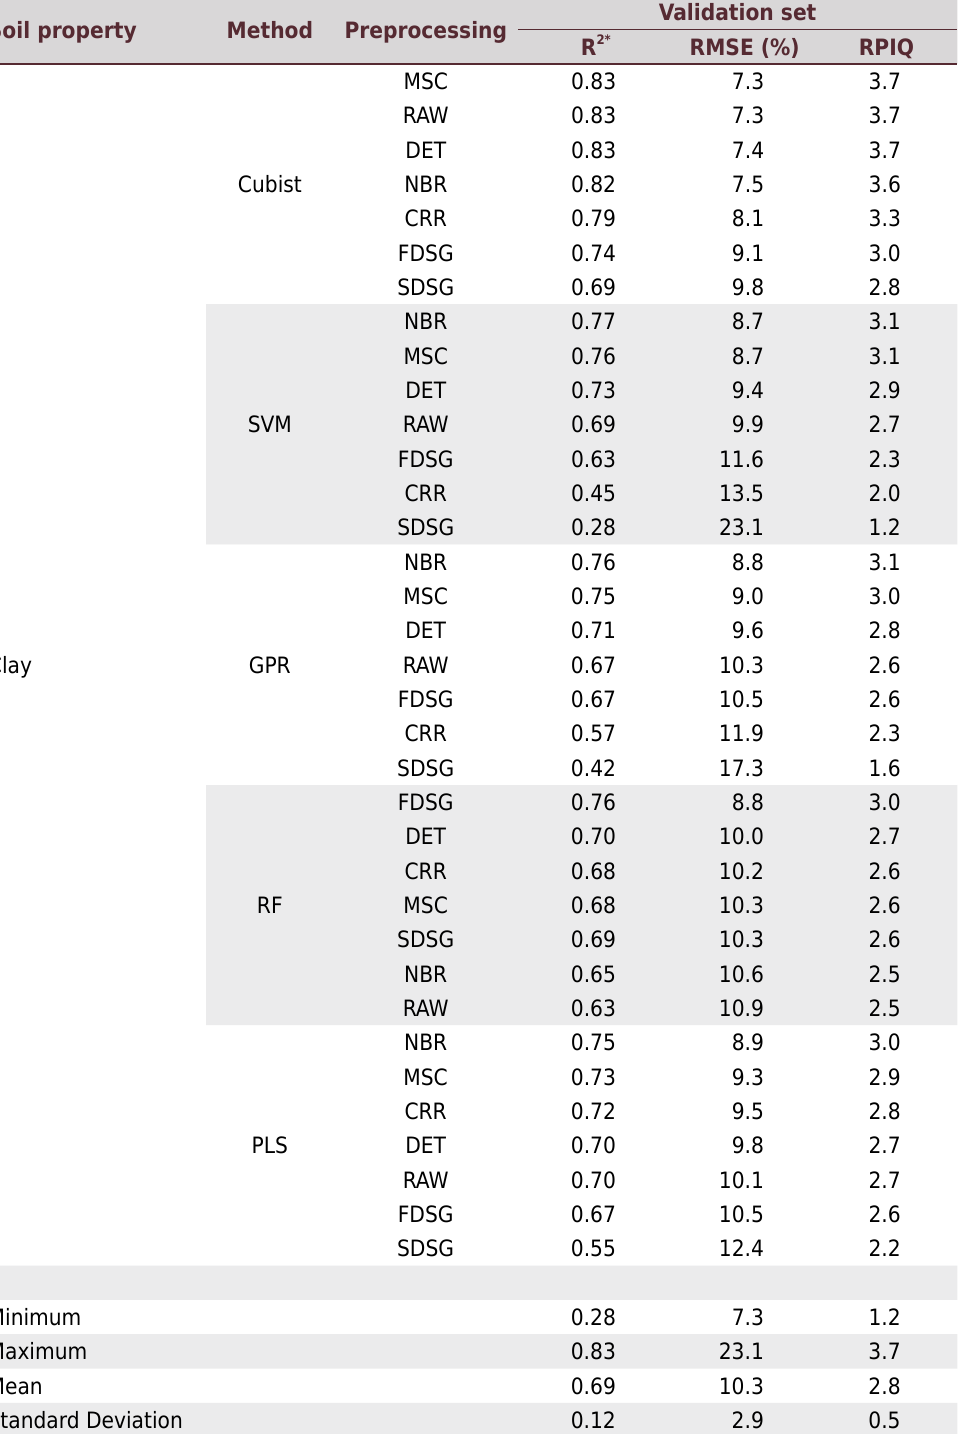
* Sorted by ascending order of R 2 (coefficient of determination for validation